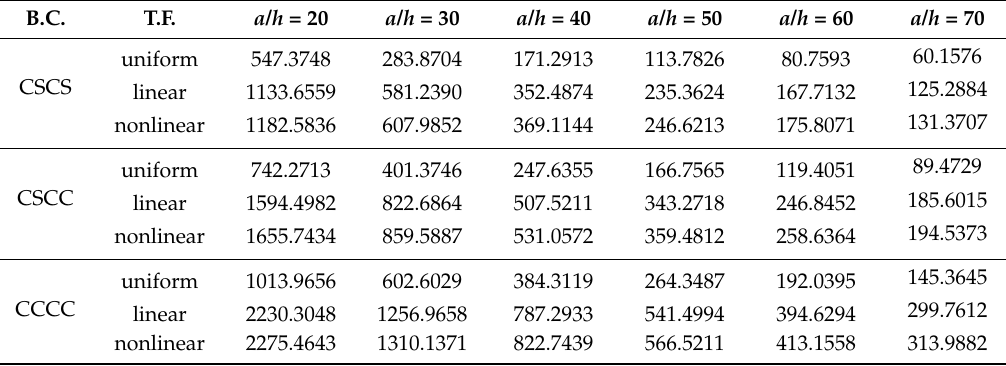
Table 10. Critical buckling temperature ∆ T cr of type-I FGM rectangular thin plate with different a / h and various B.C. ( a / b = 2, n = 2, T 0 = 300 K).